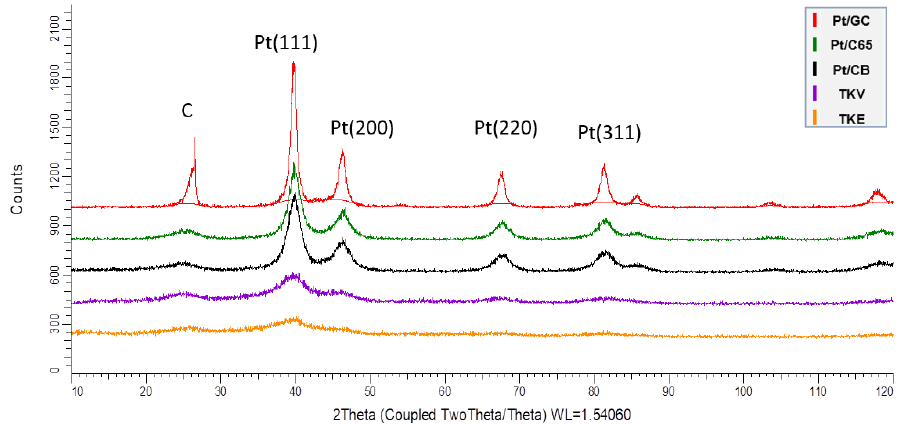
Figure 1. XRD patterns of the catalysts.